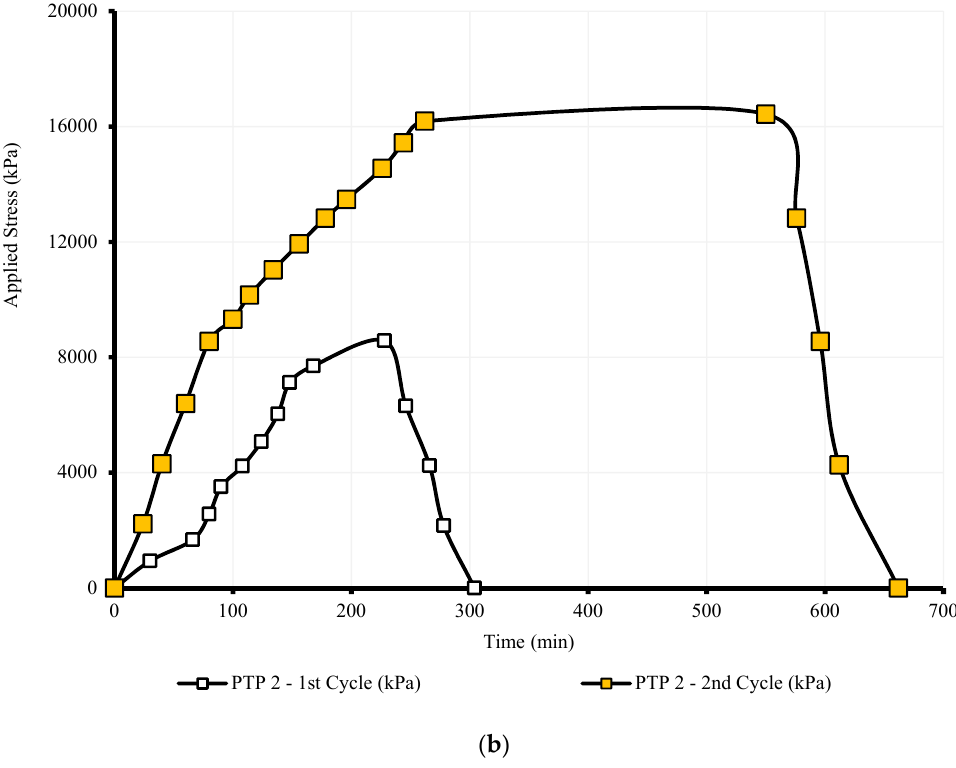
Figure 3. Variation of the total applied static stress on pile versus time, ( a ) Bored pill (BP)# 1 and ( b ) BP# 2.